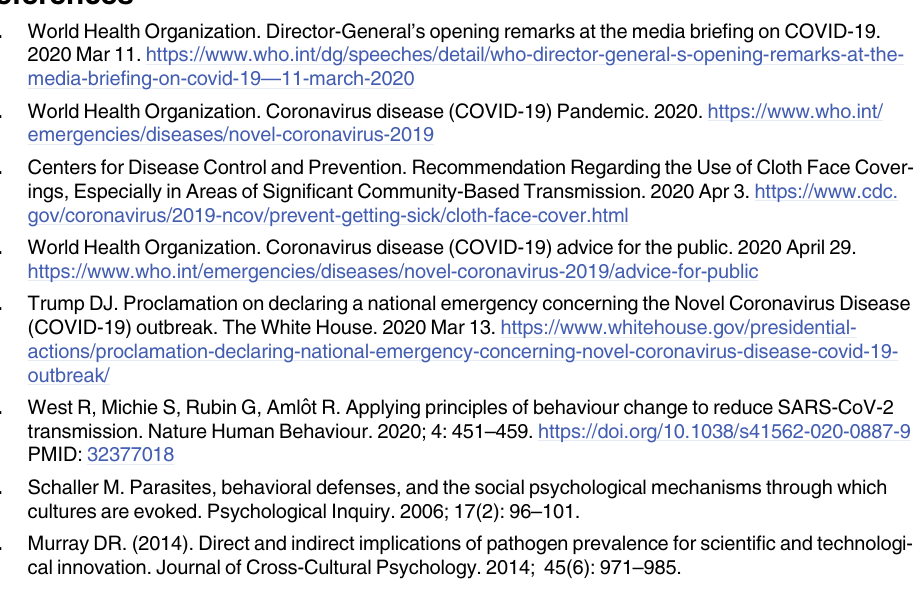
S2 Table. Regression model for social distancing. S3 Table. Regression model for avoid touching face. S4 Table. Regression model for wearing antiviral facemask. S5 Table. Regression model for handwashing. S6 Table. Regression model for